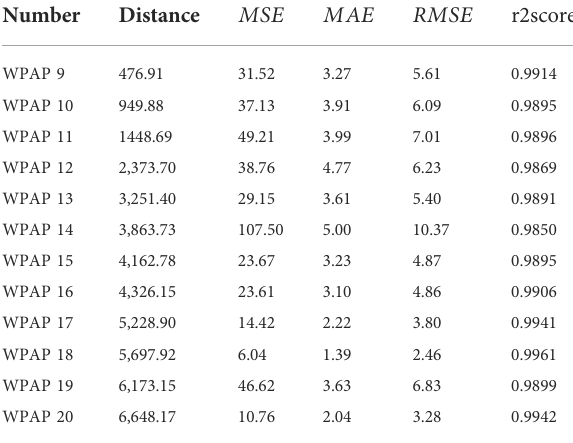
TABLE 2 Performance indicators of WPAPs 9 to 20 and the distance of relative location between each WPAP and WPAP